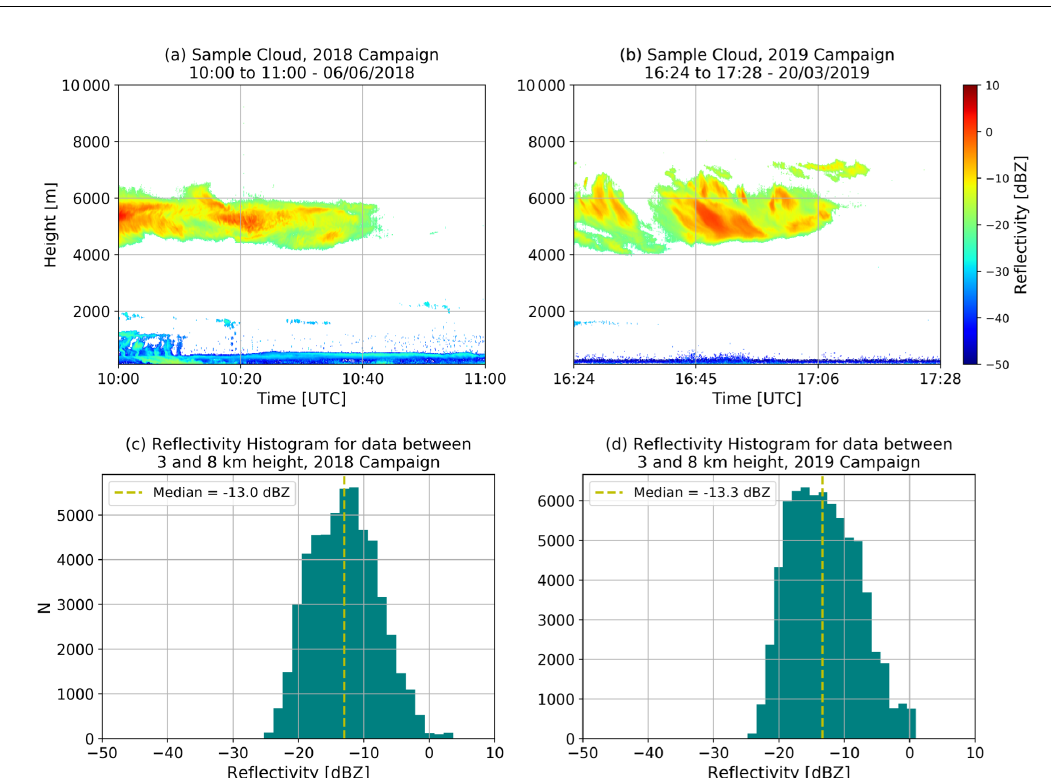
Figure 11. Altostratus cloud sampled during the 2018 (a) and 2019 campaigns (b) . Lower reflectivities are easier to capture at lower altitudes because of the lower distance and attenuation losses (Eq. 5b). In the altostratus reflectivity histograms (c, d) we observe that, for both campaigns, measurements are within the ranges reported in the